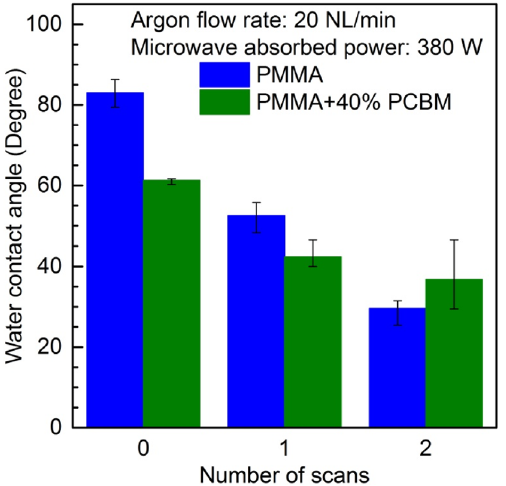
Figure 5. Effect of the plasma surface modification of PMMA polymer and PMMA + 40% PC 61 BM composite on the water contact angle as a function of the number of plasma scans. Argon flow rate 20 NL/min. Microwave power 380